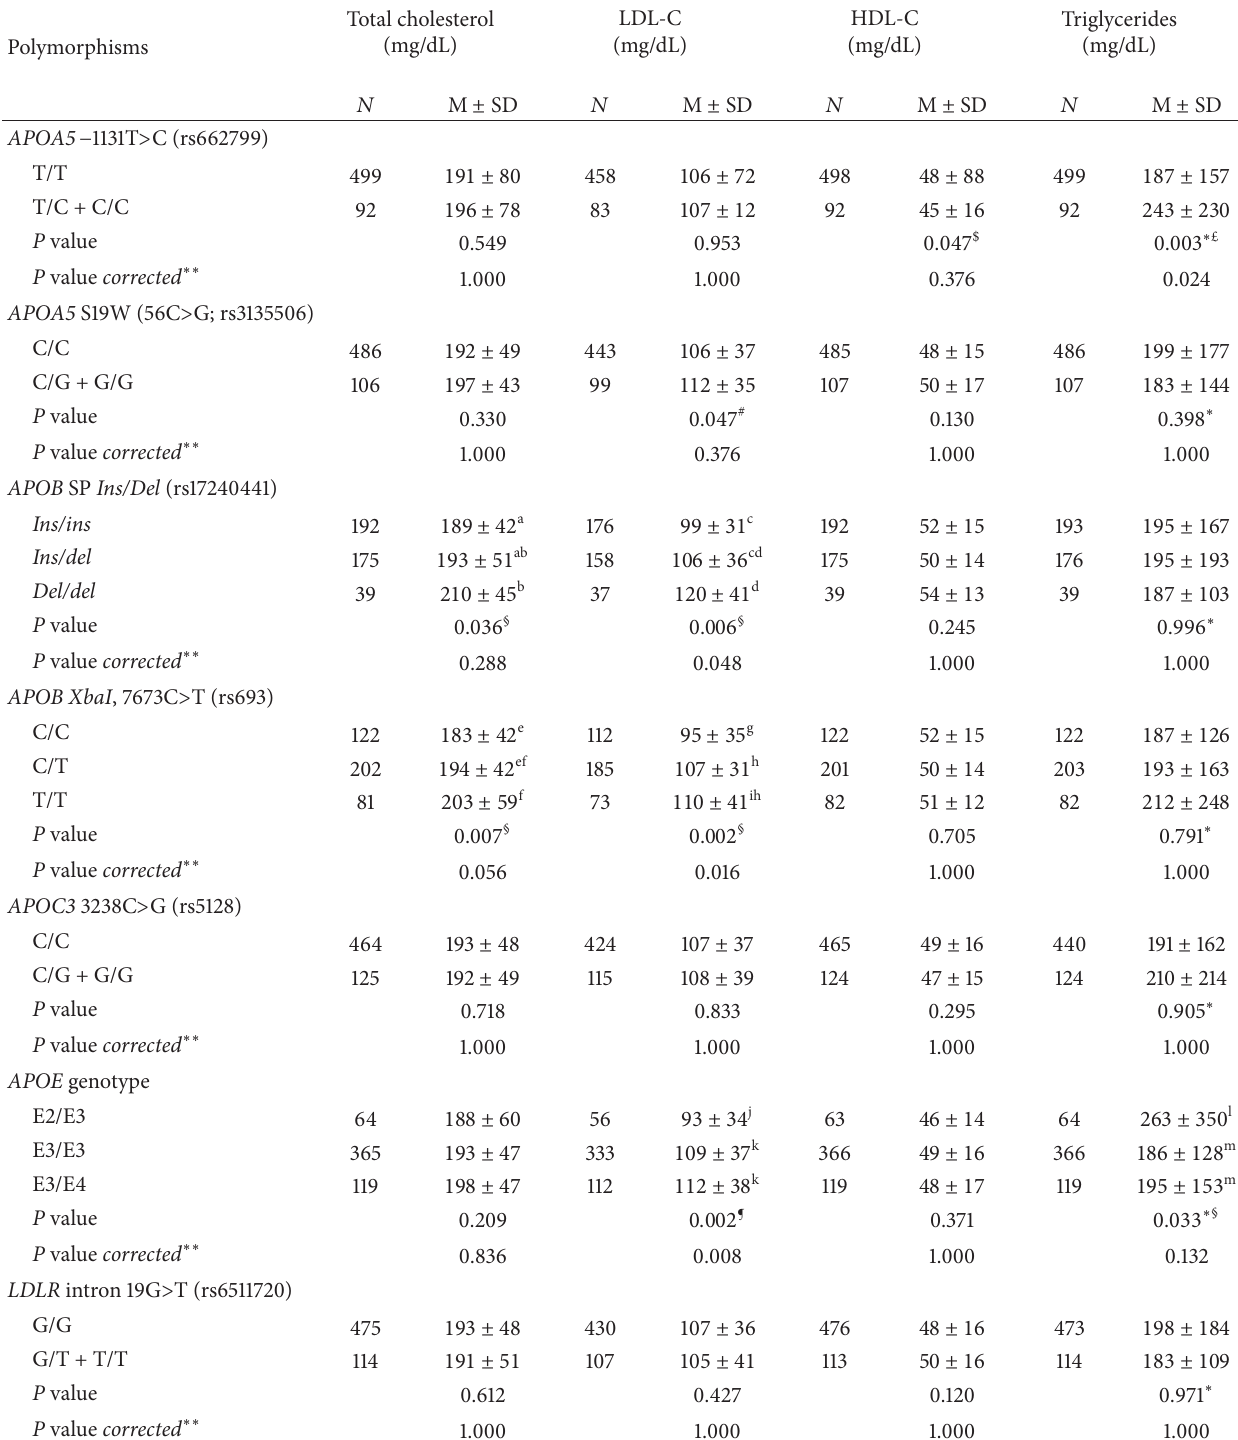
Table 3: Mean metabolic variables according to polymorphisms